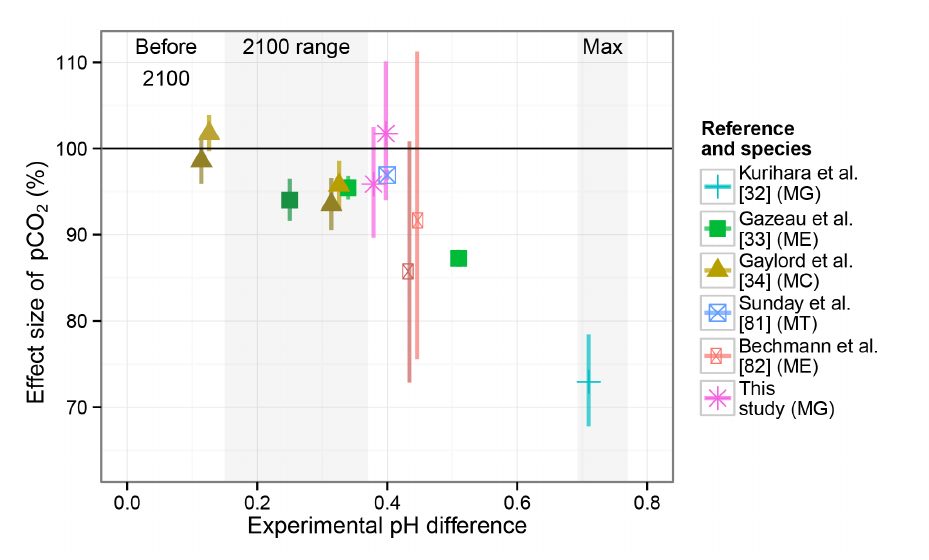
Mean effect size of p CO on growth of Mytilus larvae 48–360 h after 2 fertilization extracted from five experimental studies. Colors and symbols represent different studies. Abbreviation after the reference in legend indicates the studied species (MG = M. galloprovincialis , ME = M. edulis , MC = M. californianus , and MT = M. trossulus ). Double point for a single pH difference in a study indicates the effect measured at different times during the experiment (darker hue pinpoints the later measurement). Error bars show the 95% CIs estimated assuming a normal distribution. Rectangles with grey shading illustrate the range of IPCC SRES projected global average surface pH pathways (2100 range) [5,85] and projected IS92a maximum pH reduction following the burning of the remaining fossil-fuel resources (Max) [1]. Red points [82] have been recalculated to reflect proper levels of replication (see Section